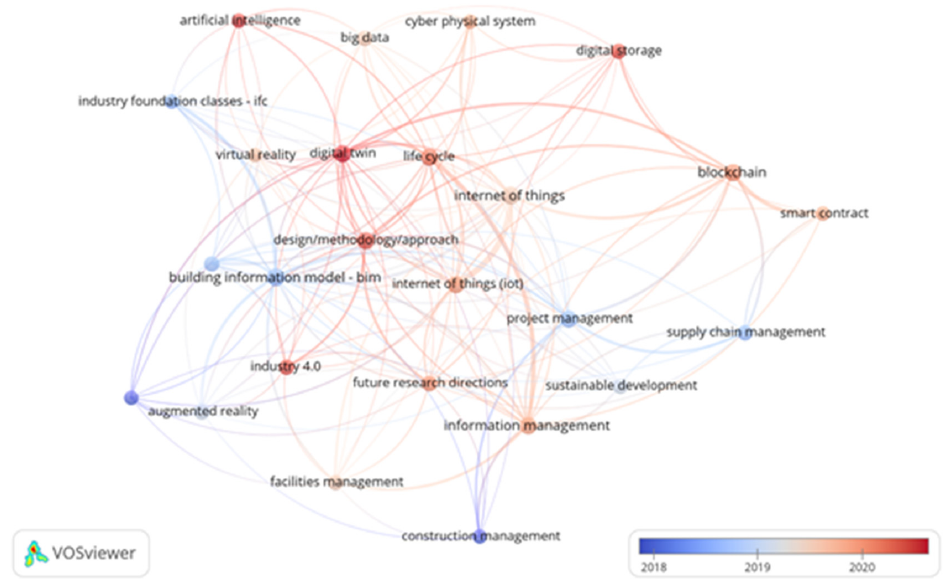
Figure 5. Overlay visualization of keywords occurrences and average publication years.